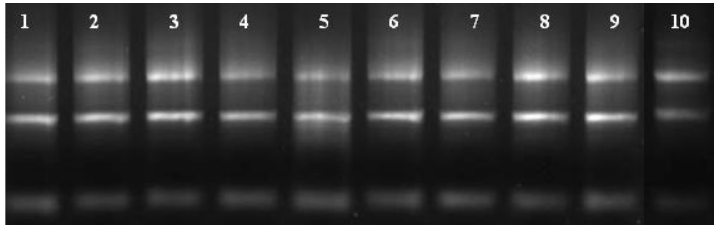
Supplementary Figure 1. Result of the gel electrophoresis of total RNA isolated from goat tissue samples. 1: heart, 2: liver, 3: spleen, 4: lung, 5: kidney, 6: stomach, 7: small intestine, 8: uterus, 9; ovary, 10: muscle. RNA samples were run on a 1% agarose gel at 100 V for 30 min. All the samples show high-quality RNA because there is a clear appearance of the 28S, 18S and 5S rRNA bands. The results indicated that total RNA was isolated successfully and with no degradation and could be used for further